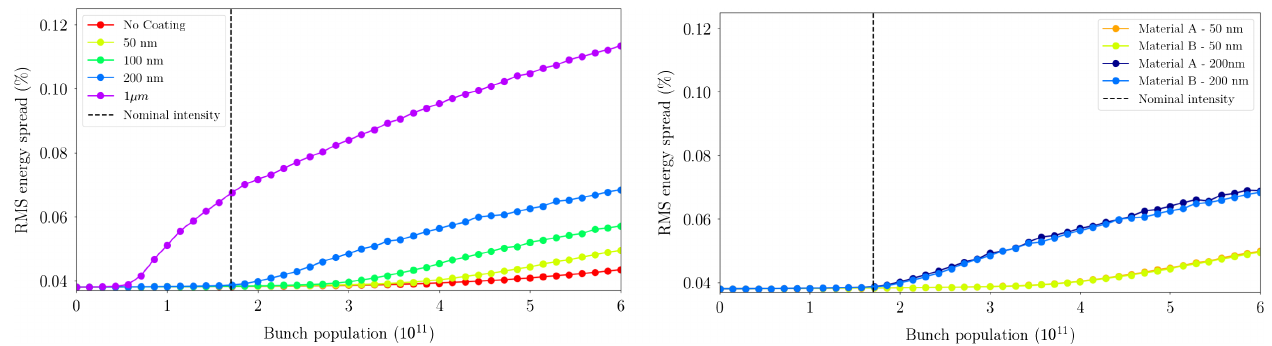
FIG. 7. Energy spread as a function of the bunch intensity obtained from numerical simulations in the case of no coating and with different thicknesses of coating B (left side) and for both materials A and B in the two cases of 50 and 200 nm thickness (right side). The other machine parameters are those of Table I with the lowest machine energy. The dashed black line corresponds to the nominal bunch